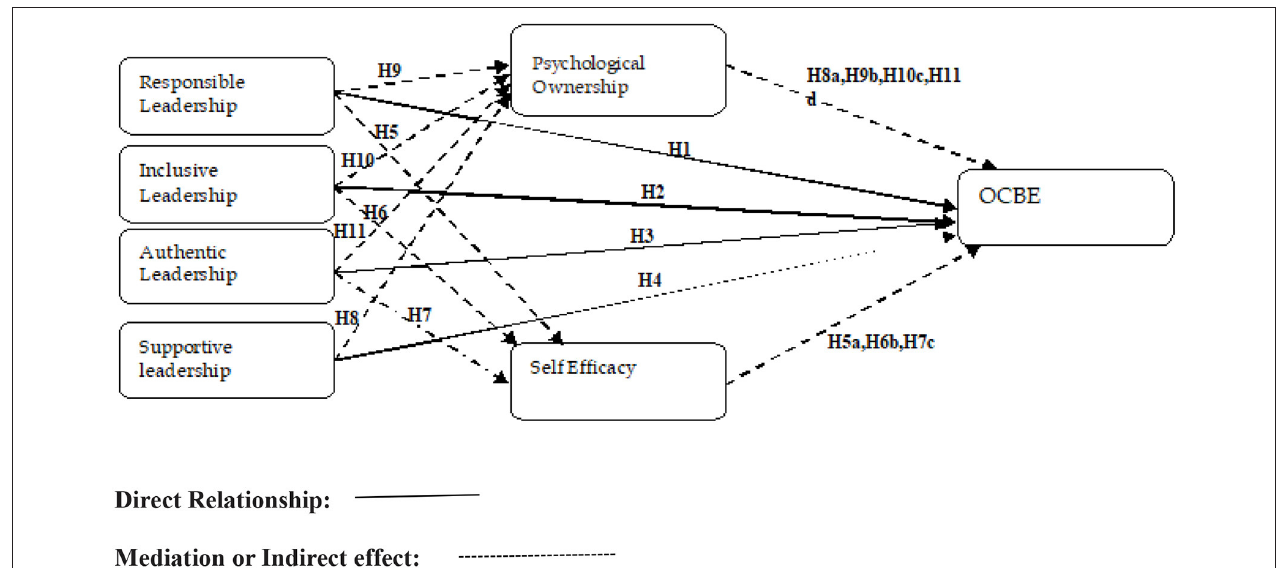
FIGURE 1 | Research